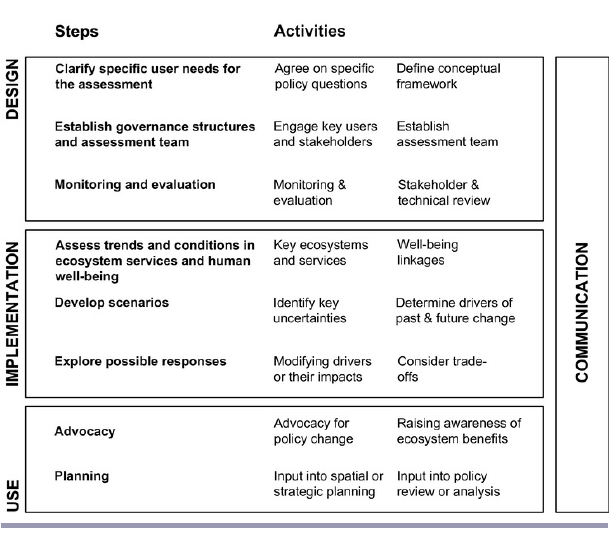
Fig. 1 . Key components of the subnational assessment processes.